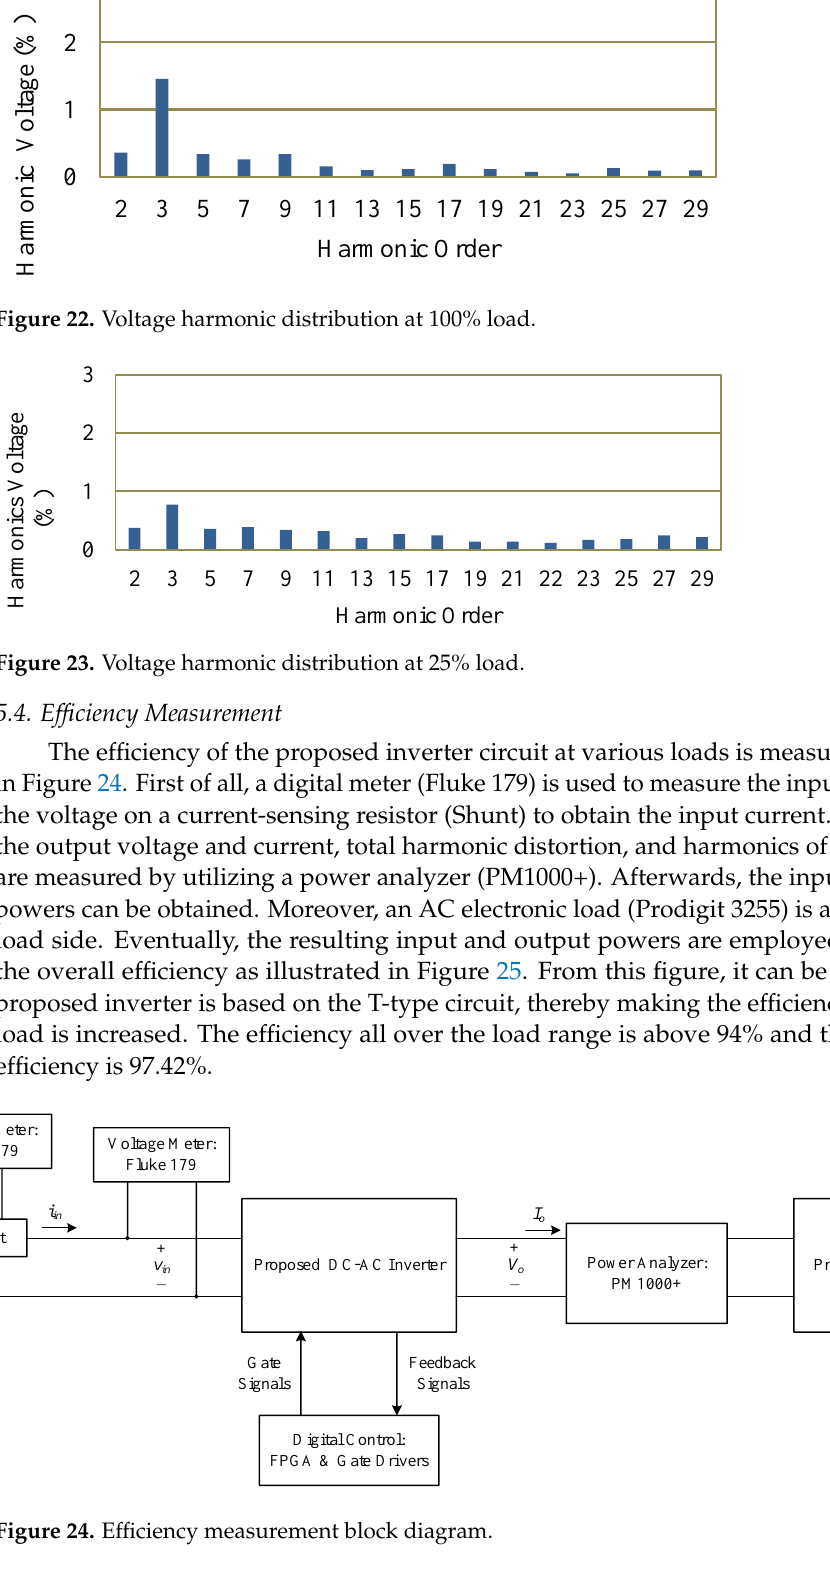
Figure 25. Curves of Efficiency against load.